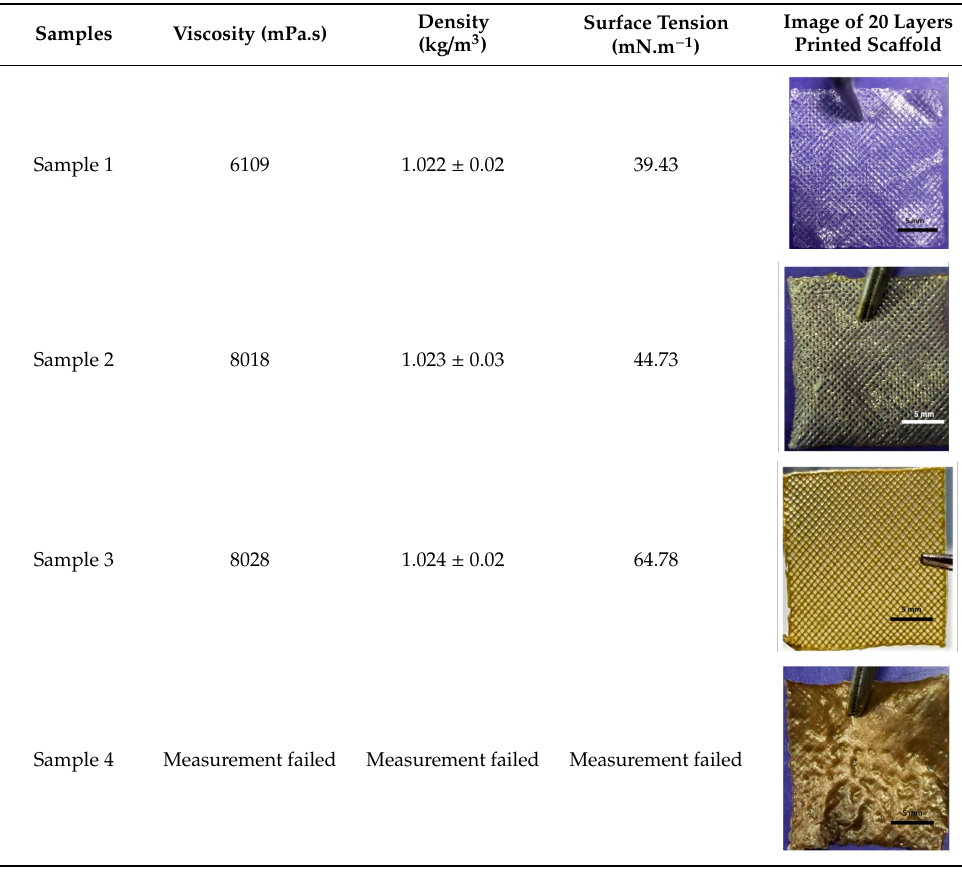
Table 2. Physical properties summary of sca ff